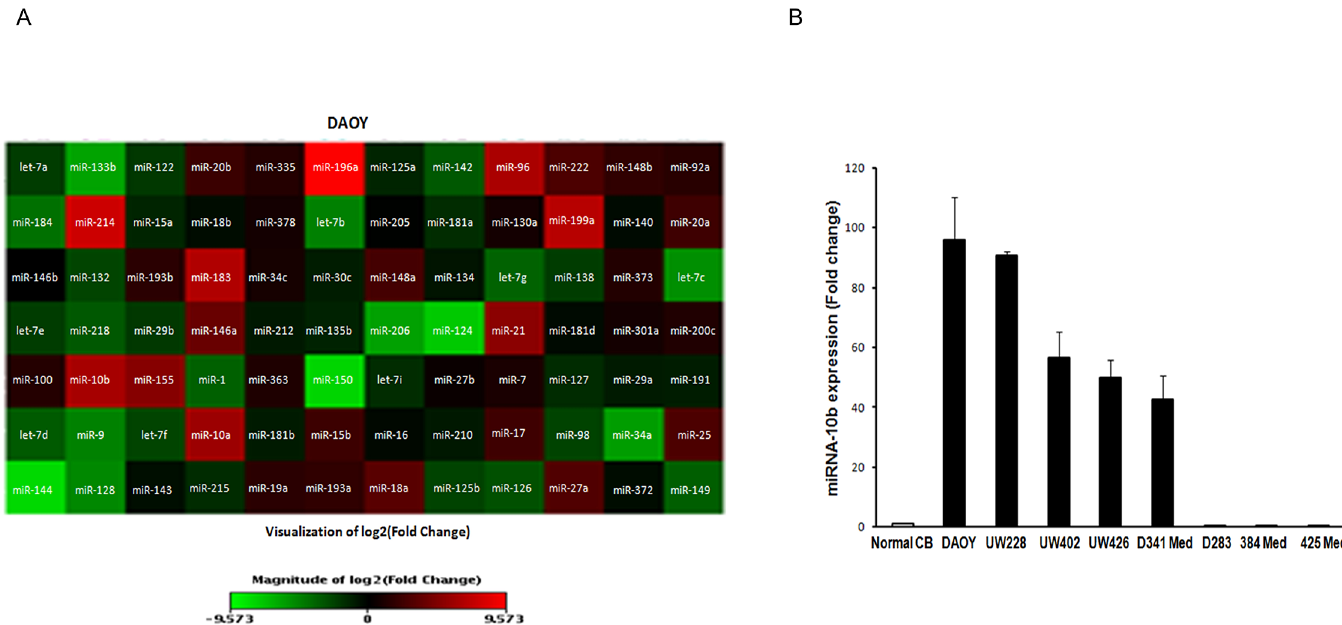
Fig 1. miRNA-10b is highly expressed in medulloblastoma cells. Total RNA was extracted from medulloblastoma cells and subjected to RT-PCR analysis. (A) Oncomir microarray using quantitative RT-PCR in DAOY cells compared to normal cerebellum and FirstChoice 1 Human Brain Reference RNA. MicroRNA heat map profile. (B) Increased expression of miRNA-10b in the majority of medulloblastoma cell lines (DAOY, UW228, UW402, UW426 and D341